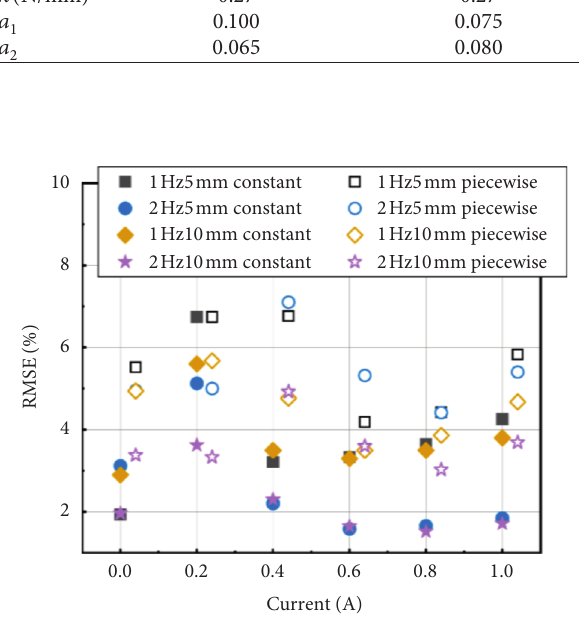
Figure 2: RMSE comparison for various